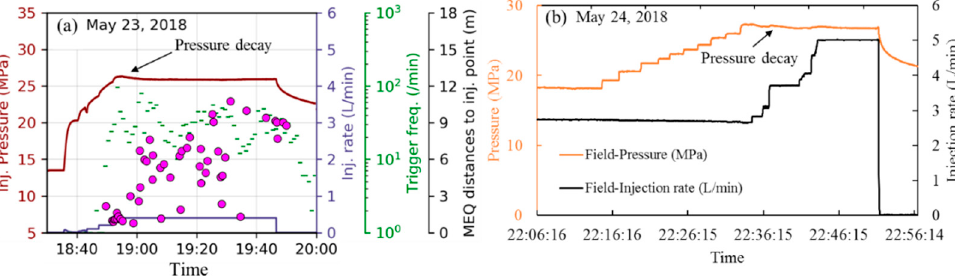
Figure 6. Injection profiles and induced seismicity for Stim-II HF ∼ = 164 Notch [2]. ( a ) The injection profiles of the test on 23 May 2018. The green dots represent the micro-seismic events per minutes. The pink dots represent the distance between events and the Notch ∼ = 164. ( b ) The injection profiles (SNL14) of the test on 24 May 2018.